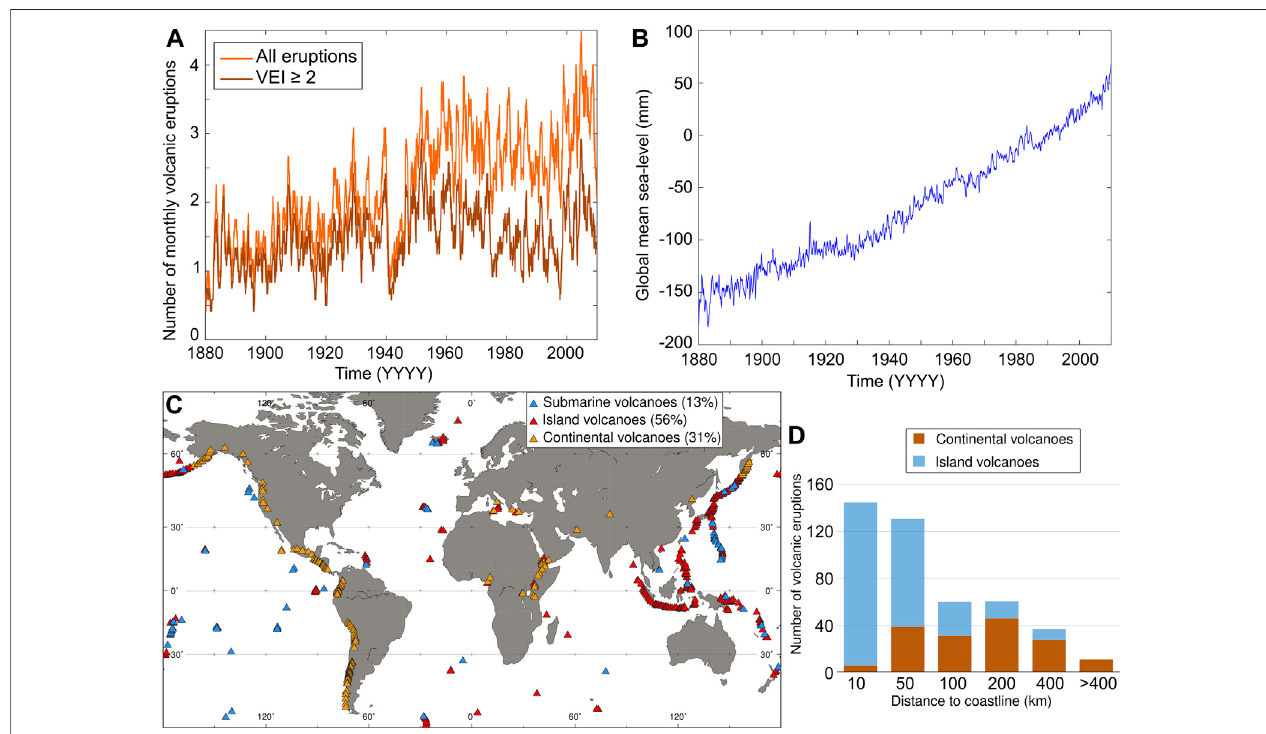
FIGURE1| Global volcanicactivity and global meansea level from 1880 to2009. (A) Curves showing thenumber ofcon fi rmed monthlyvolcanic eruptions since 1 January 1880to31 December 2009 forall and VEI ≥ 2eruptions (GlobalVolcanism Program, 2013).Theseeruptions areassociatedwith 514volcanic systems shown in (C) . The colorofthe triangles corresponds to submarine (blue), island(red) or continental (orange)volcanicsystems whose proportions areindicatedin the topinset (C) . (B) CurveoftheglobalmeansealevelfromJanuary1880toDecember2009afterChurchandWhite(2006). (D) Histogramshowingthedistancetothecoastlinefor the 161 continental and 284 island volcanoes (total: